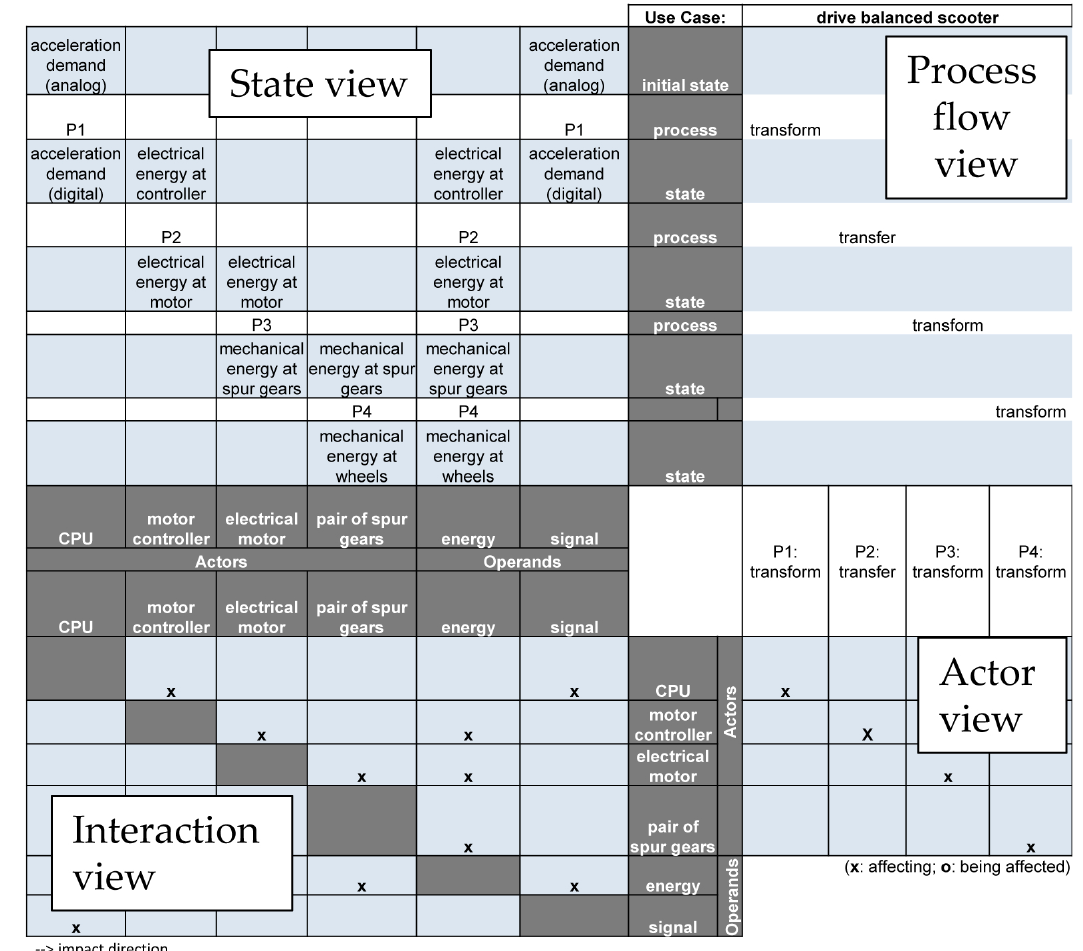
Figure 8. Associated views in the IFM framework.